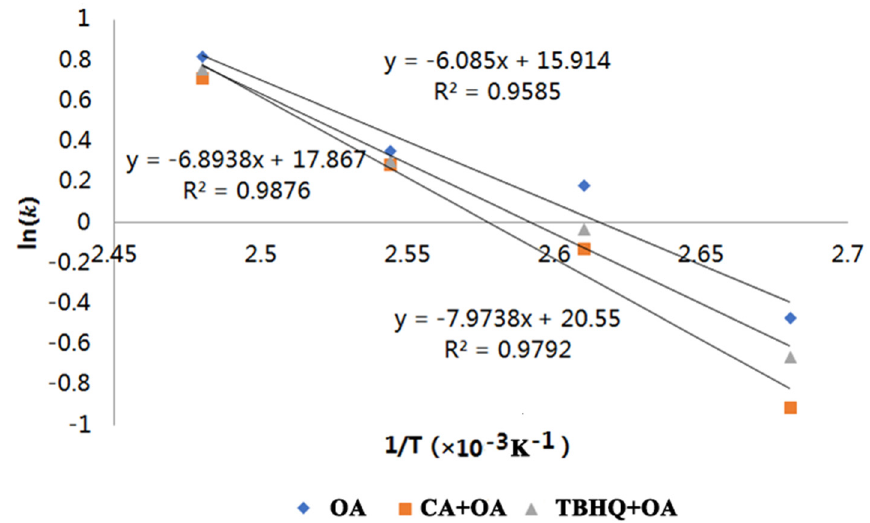
Figure 2. Reaction model of CA against the oxidation of OA (2#).